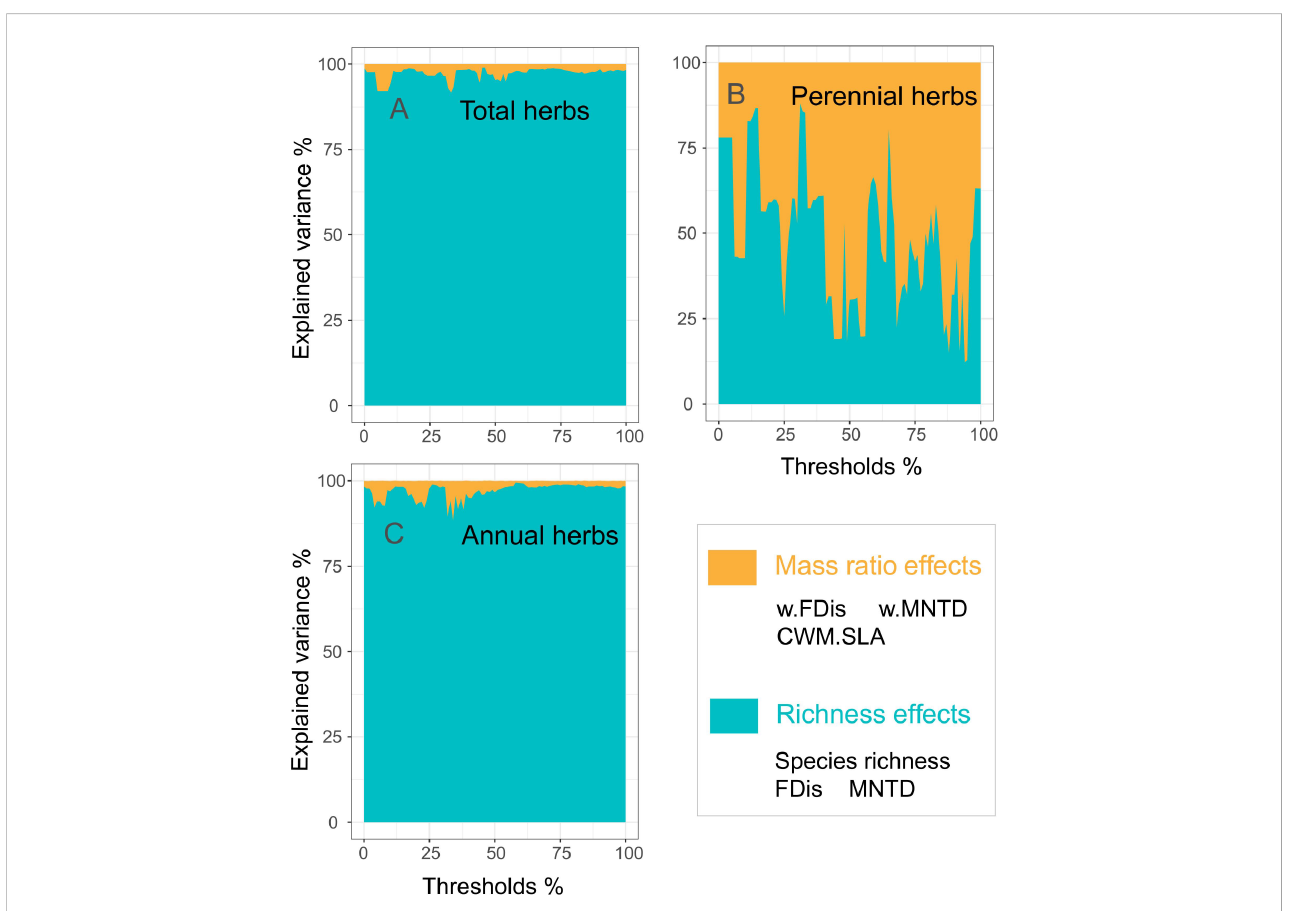
FIGURE 1 Mass ratio and richness effects of herbs were signi fi cant for multifunctionality. The signi fi cance of the predictor variables is expressed as the percentage of variation they explain and is based on the absolute value of their standardized regression coef fi cients ( A , total herbs; B , perennial herbs; C , annuals herbs). Abbreviaions are as in Table